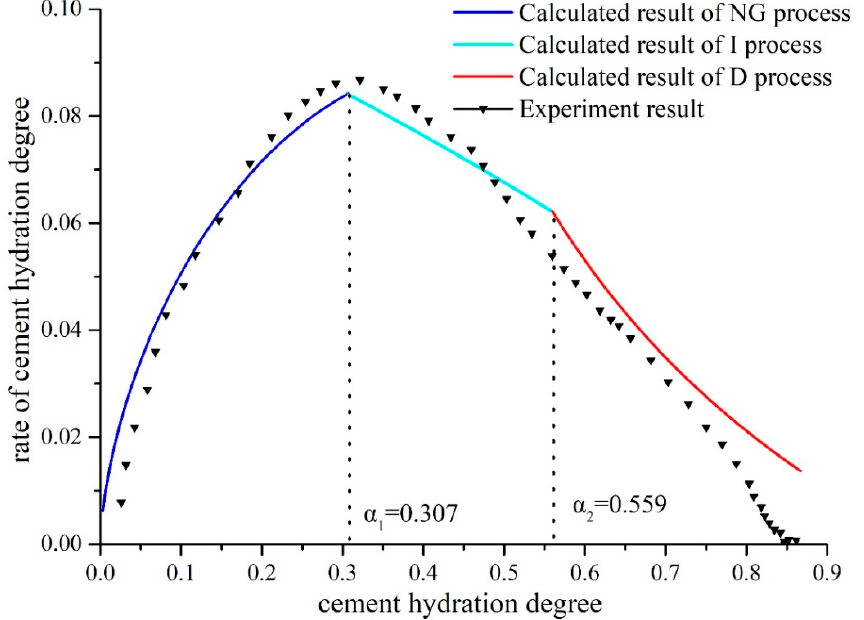
Figure 3. Comparison between the calculated and experimental results of the hydration process at 65.5 °C.